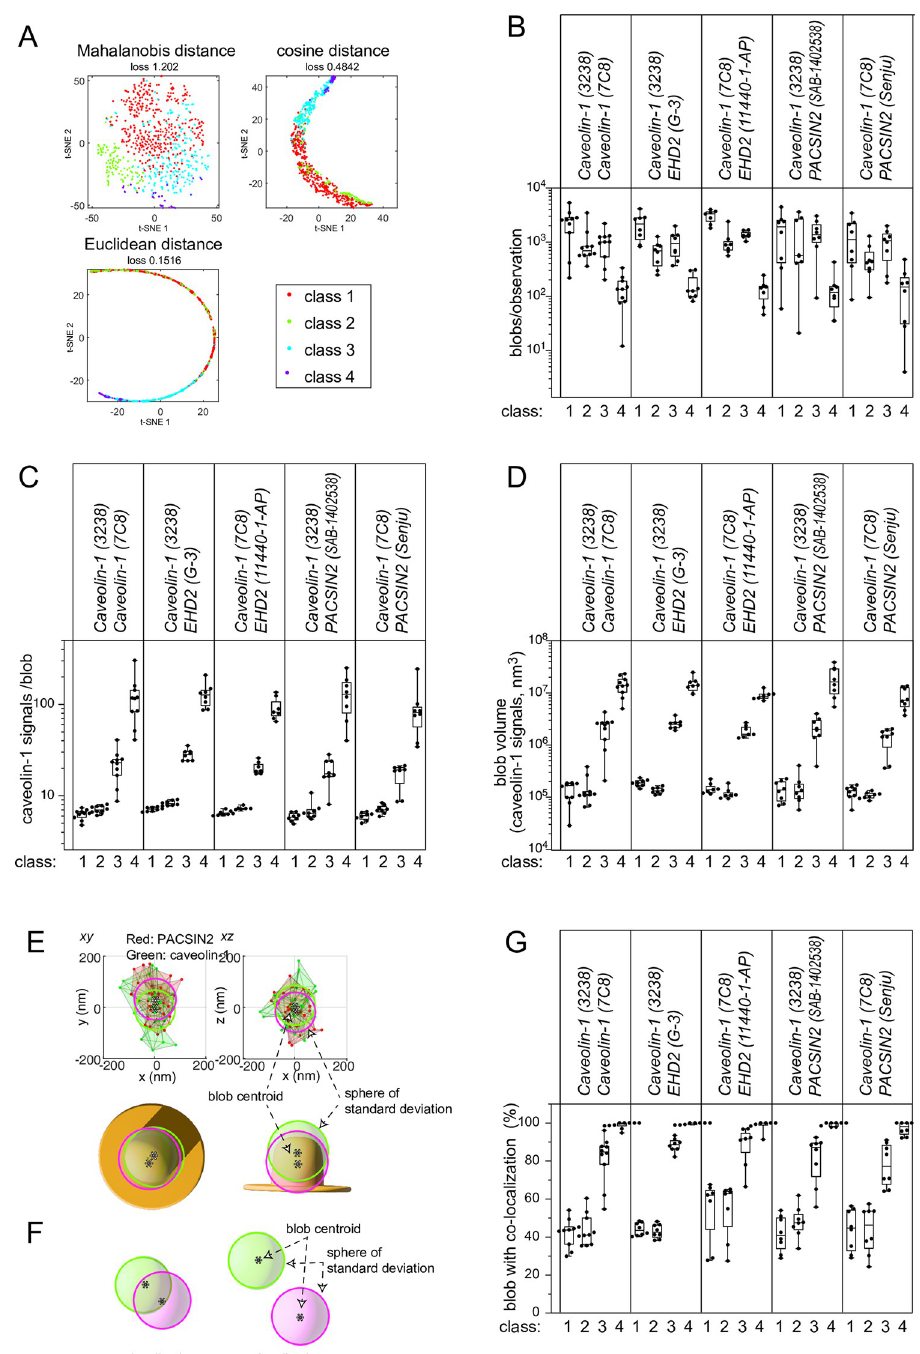
Fig 2. Clustering of caveolin-1 into blobs and co-localization with PACSIN2 or EHD2. (A) Typical clustering results of caveolin-1 signals of blobs from a cell into groups according to proximity by SuperResNet and their projections by t-SNE with Mahalanobis distance, cosine distance, and Euclidean distance. (B) The number of each class of caveolin-1 blobs per observation. (C) The average number of caveolin-1 signals from a blob of each class per observation. (D) The average volume of each class of caveolin-1 blobs per observation. In (B-D), the dot represents an average from an observation, which typically contained a cell. N = 6–10 observations for each combination of antibodies. (E) A caveolin-1 blob containing PACSIN2. Each signal of PACSIN2 and caveolin-1 is shown as a dot, and the signals within 80 nm of each other are connected by lines. The centroids of the caveolin-1 and PACSIN2 signals are illustrated by � , with spheres based on the radii of the standard deviations of caveolin-1 and PACSIN2. (F)